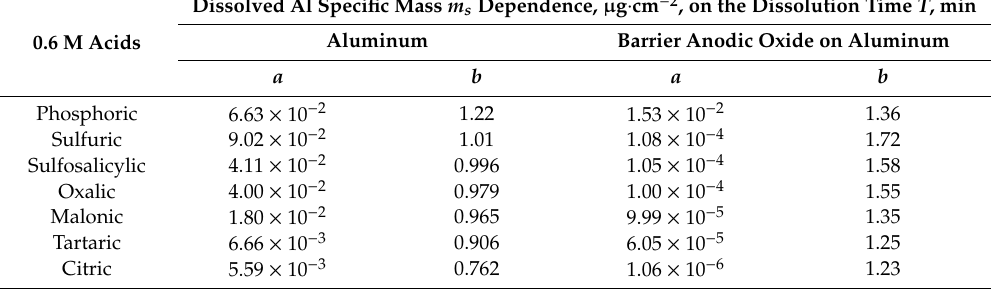
Table 1. Empirical constants from Equation (4) for calculating the mass of dissolved aluminum vs. that for 0.6 M solutions of phosphoric, sulfuric, sulfosalicylic, oxalic, malonic, tartaric, and citric